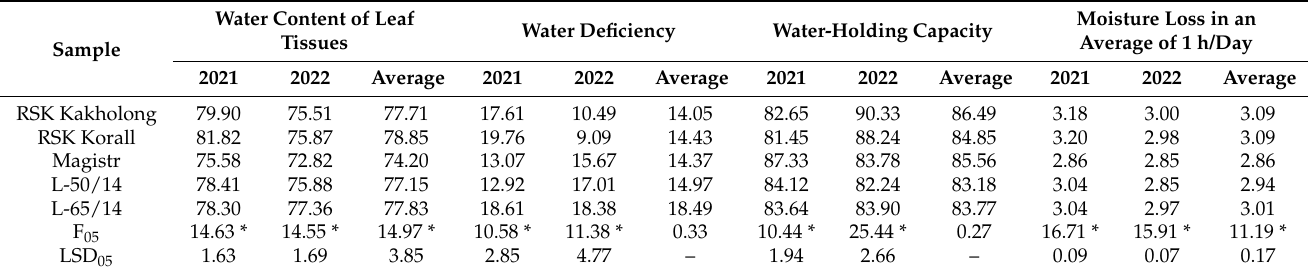
Table 4. Parameters of the water regime of leaves of grain sorghum samples (2021–2022), %.